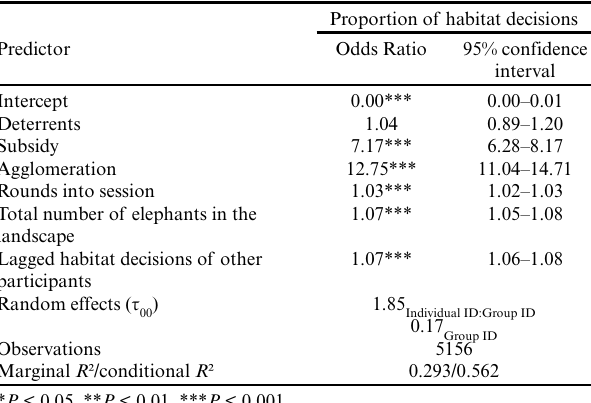
Table 3. Odds ratio estimates from the reduced generalized linear mixed model showing the effect of treatments and other fixed effects on farmers’ propensity to provide habitats in the games. Individuals and groups were included as random